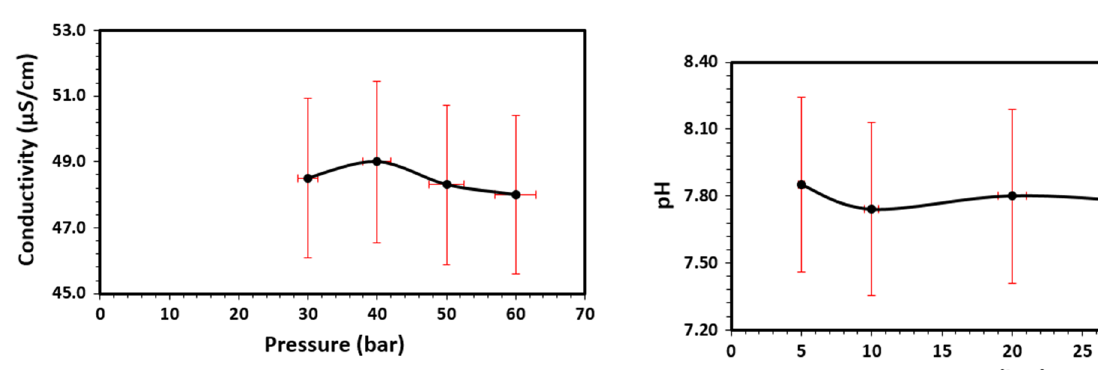
Fig. 11 Effect of different applied pressures on the pH value of the Red Sea water in membrane #1 (FP100)